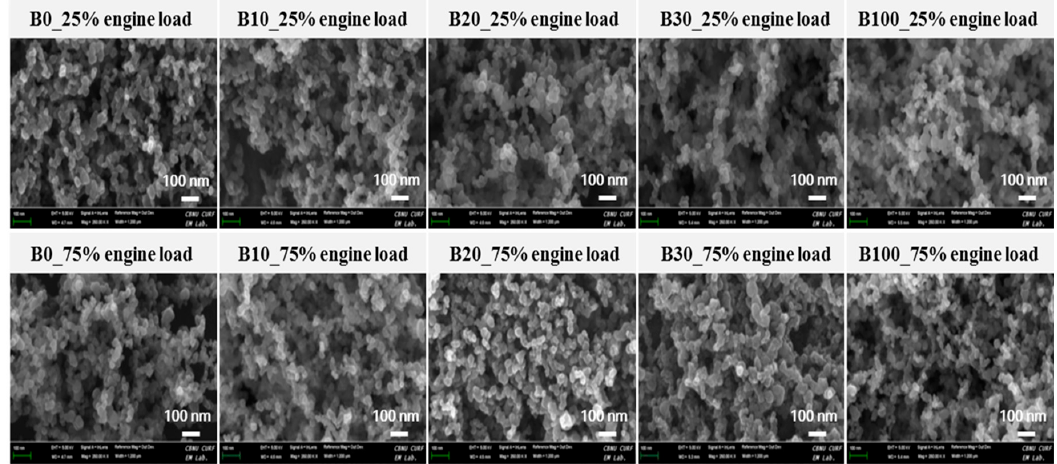
Figure 9. Comparisons of SEM images of the PM primary particles at 25% and 75% engine loads.